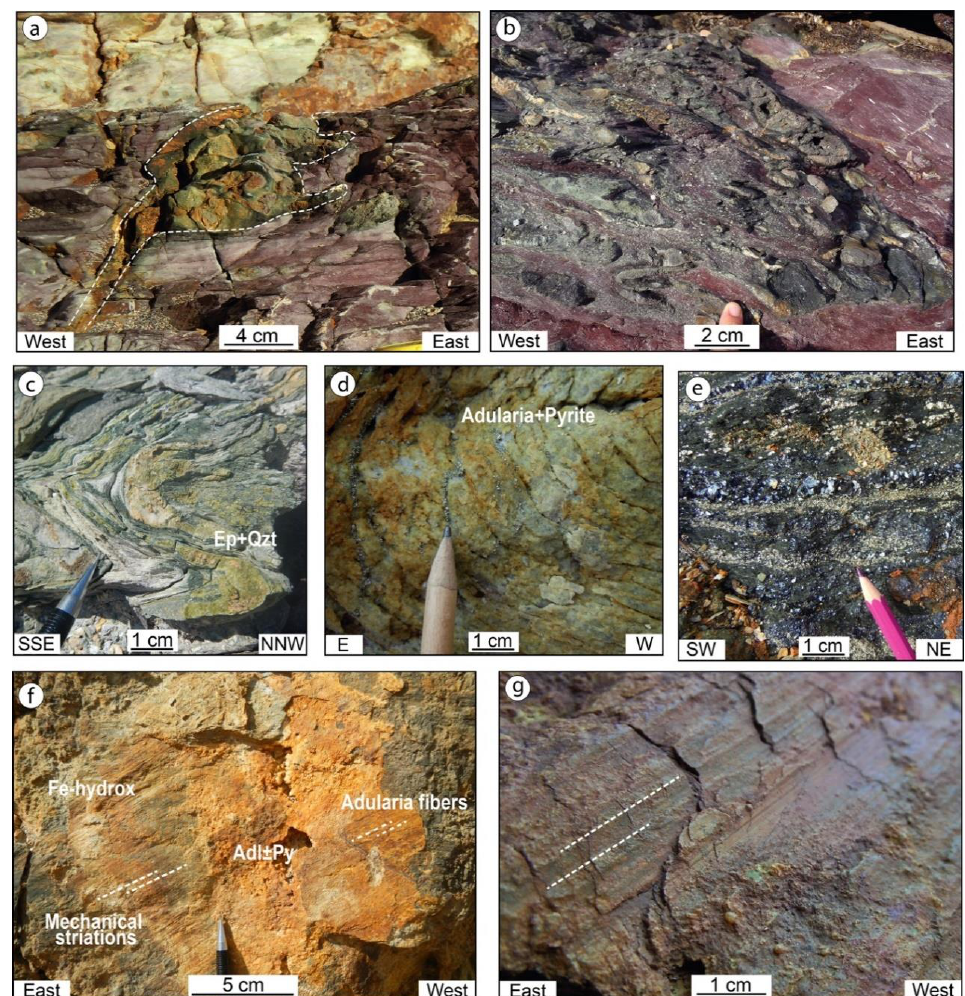
Figure 11. Photos of outcrops of Fe-oxides and Fe-hydroxides bearing quartzite; ( a ) Fe-hydroxide vein settled along a fracture: the paleofluid laterally migrated, where the texture of the rock was suitable to host fluid flow; ( b ) the metasomatic process is selective, being efficient in the quartz-metasandstone only, while phyllite (violet) remains basically impervious; ( c ) detail of former sedimentary levels selectively metasomatized by epidote and quartz; ( d ) pyrite and adularia veinlets along the foliation of quartzite: the fluid flow followed pre-existing discontinuities; ( e ) metasomatism affects the entire level, thus forming an ore deposit of pyrite and hematite; ( f ) fault slip surface characterized by syn-kinematic adularia and Fe-hydroxides fibers and mechanical striations; ( g ) example of dominant oblique slip movement in a fault-plane Fe-hydroxide shear vein. Mineral abbreviation from Reference